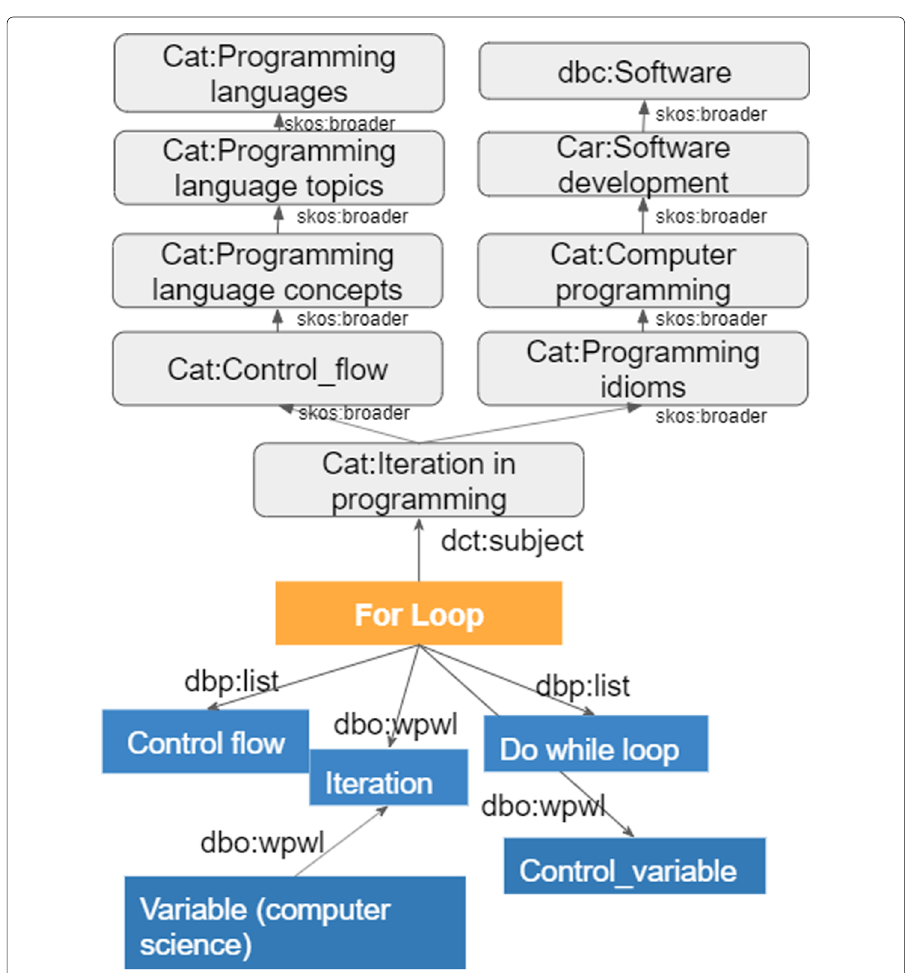
Fig. 1 Fragment of hierarchical (gray boxes) and non-hierarchical (blue boxes) knowledge for the “ For Loop ” concept extracted from DBpedia